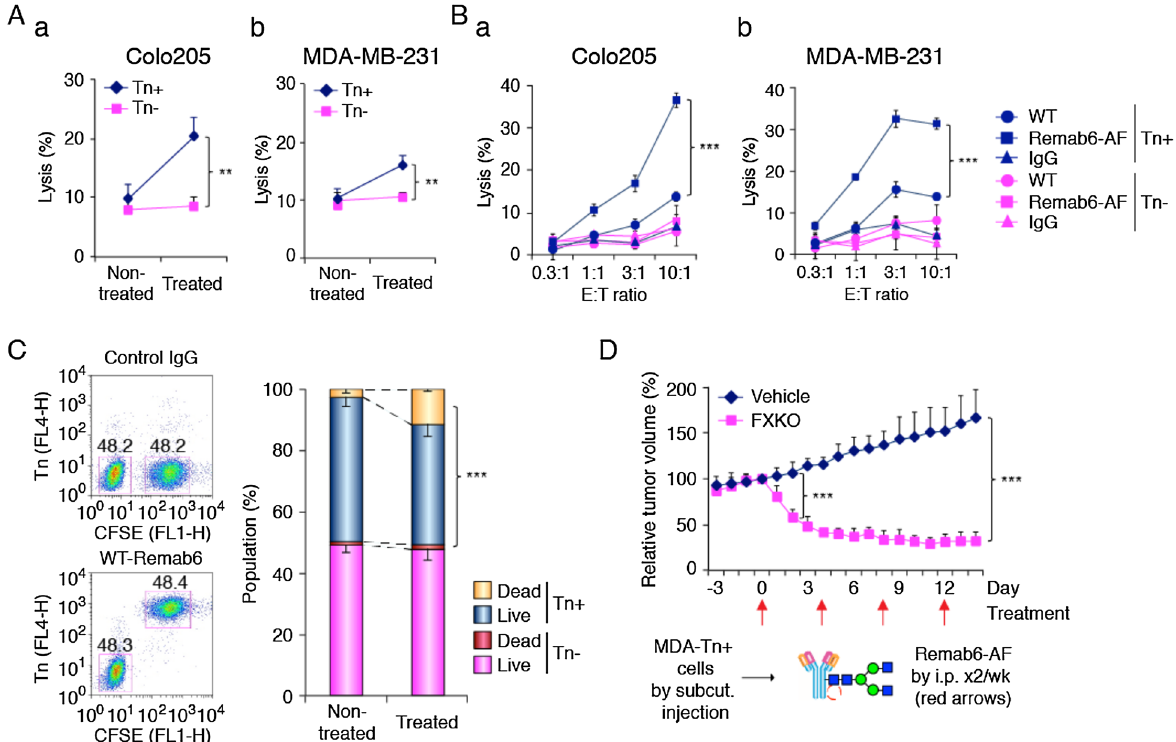
Figure 3. Selective cell cytotoxicity with glycoengineered anti-Tn mAb in Tn+ human carcinoma cell lines in vitro and in vivo. ( A ) Human carcinoma cell lines (Colo205, a ; MDA-MB-231, b ) and their Cosmc -KO cell lines (SimpleCell, Tn+) incubated with WT-Remab6 (5 μg/mL) in the presence of human serum. CDC activity measured by flow cytometry with single positive Annexin V or PI, and double positive Annexin V + PI. Error bars represent ± one SD with three independent experiments (n = 3, each). ( B ) ADCC activity assayed with WT- or Remab6-AF (5 μg/mL) in Colo205 ( a ) or MDA-MB-231 ( b ) cell lines co-cultured with human PBMCs. The ratio of effector cells and tumor cells (E:T) indicated. % lysis assessed by LDH exposure. Error bars represent ± one SD with triplicates (n = 3, each). Graphs show one representative of three independent experiments (n = 3). ( C ) Colo205-Tn+ cells pre-stained with CFSE dye, and mixed with Tn− cells at 1:1 ratio. WT-Remab6 staining analyzed by flow cytometry. CDC activity with WT-Remab6 assessed with 7-AAD staining. Error bars represent ± one SD with three independent experiments (n = 3). ( D ) MDA-MB-231 cell line (Tn+) subcutaneously inoculated into nude mice and treated with Remab6-AF (200 μg/mice by i.p.) or vehicle (PBS) twice a week indicated by red arrows. Graph plotted as relative tumor volume (RTV) vs. Day of treatment. Error bars represent ± one SD (n = 5, each). **, p < 0.01, ***, p < 0.001, Student’s t